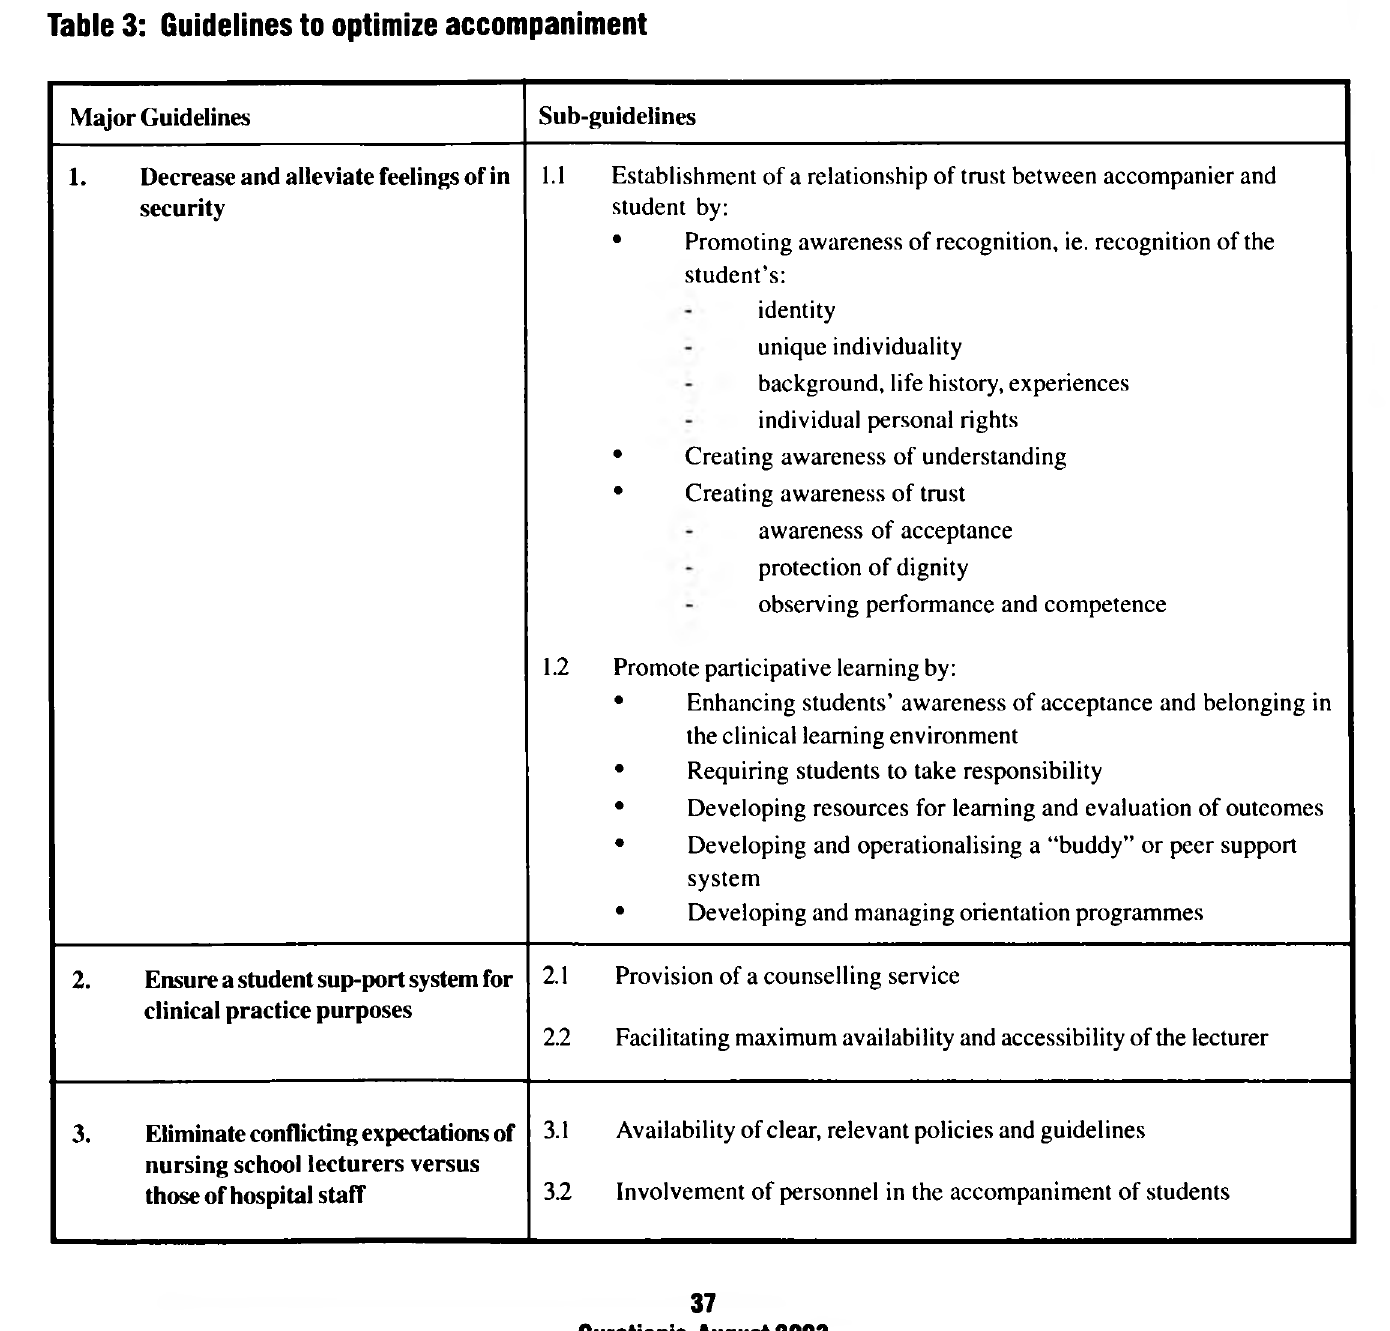
Table 3: Guidelines to optimize